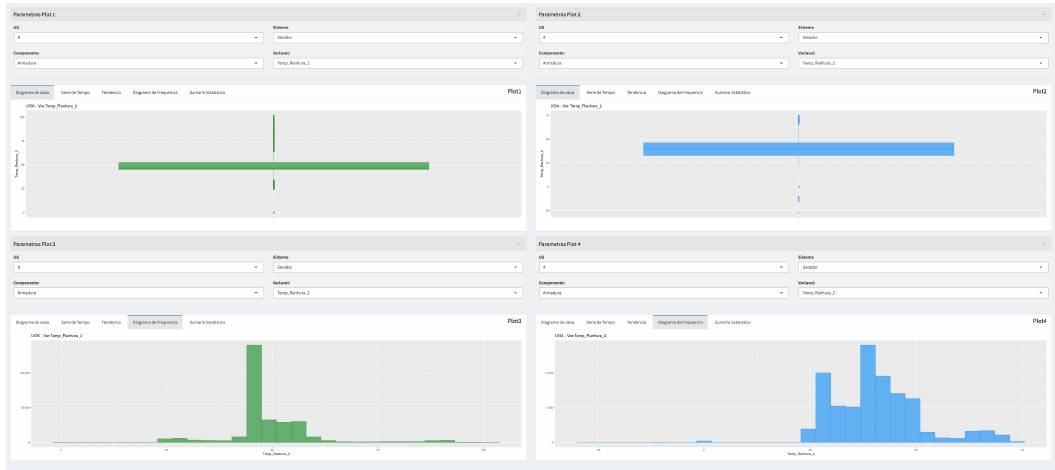
Figure 7. Rotor Groove—Comparison GU4 vs. GU6—Boxplot and